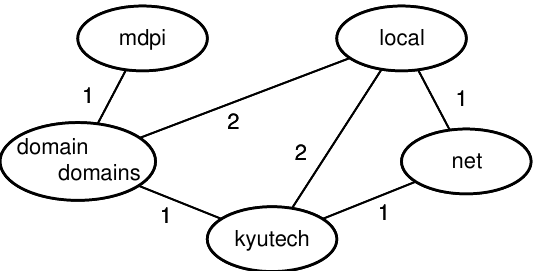
Figure 3. Example of constructing a word graph using a set of word groups.